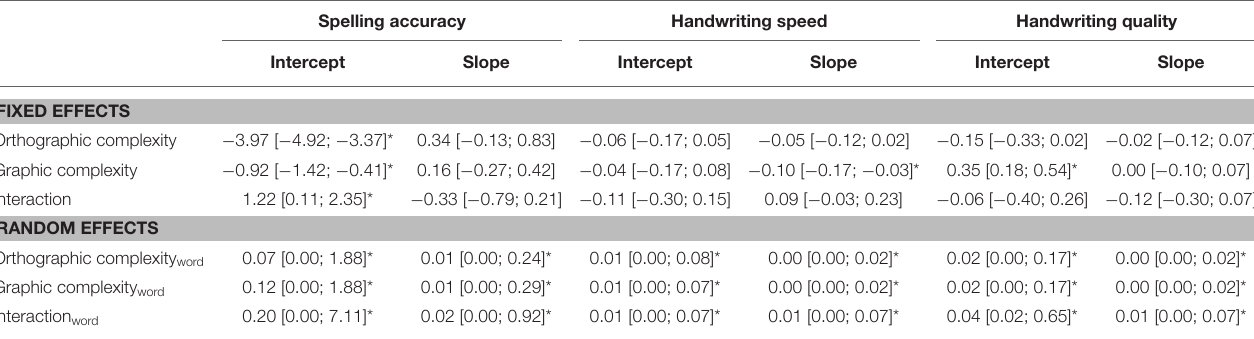
TABLE 5 | Estimates of the conditional linear growth curve models of spelling, handwriting speed, and handwriting quality on orthographic and graphic complexity in cohort